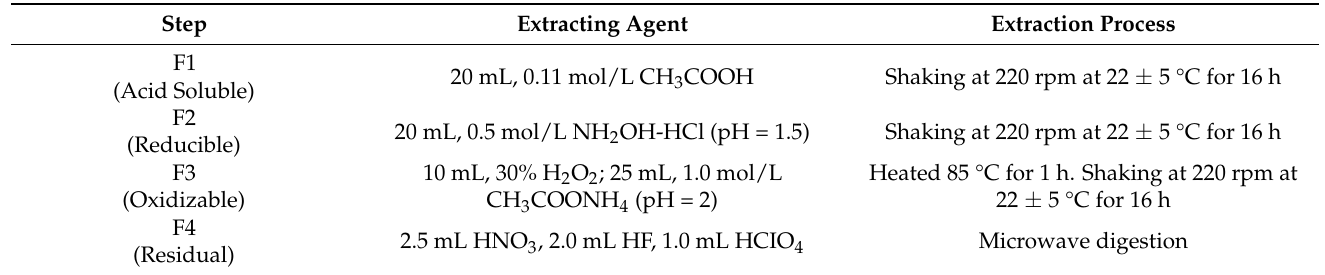
Table 1. Improved BCR sequential extraction